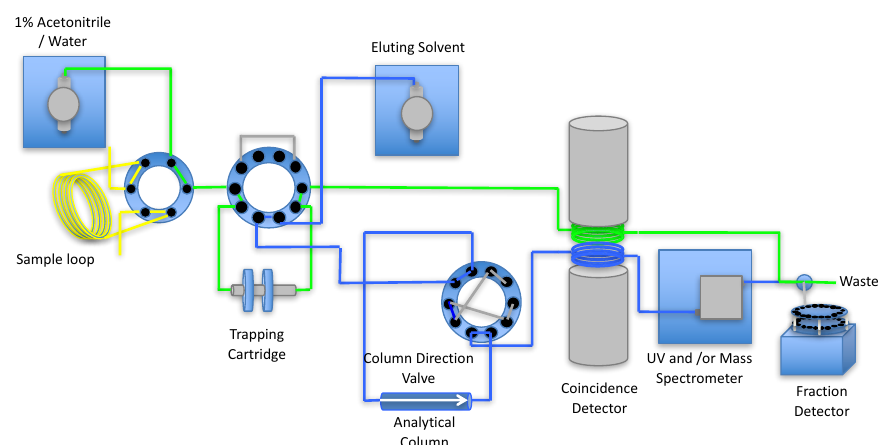
Figure 3. Equilibration of the trapping cartridge and analytical column.